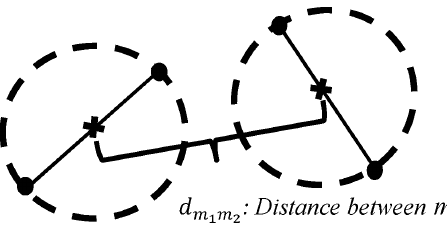
Figure 6. Calculation of distance between midpoints for two segments.